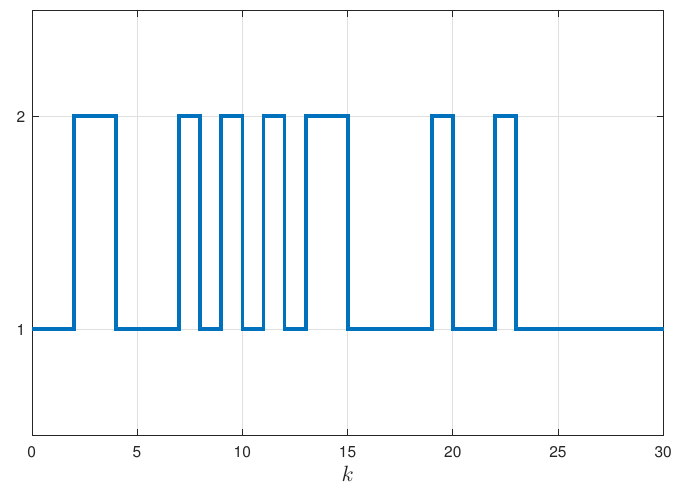
Figure 5. Failure